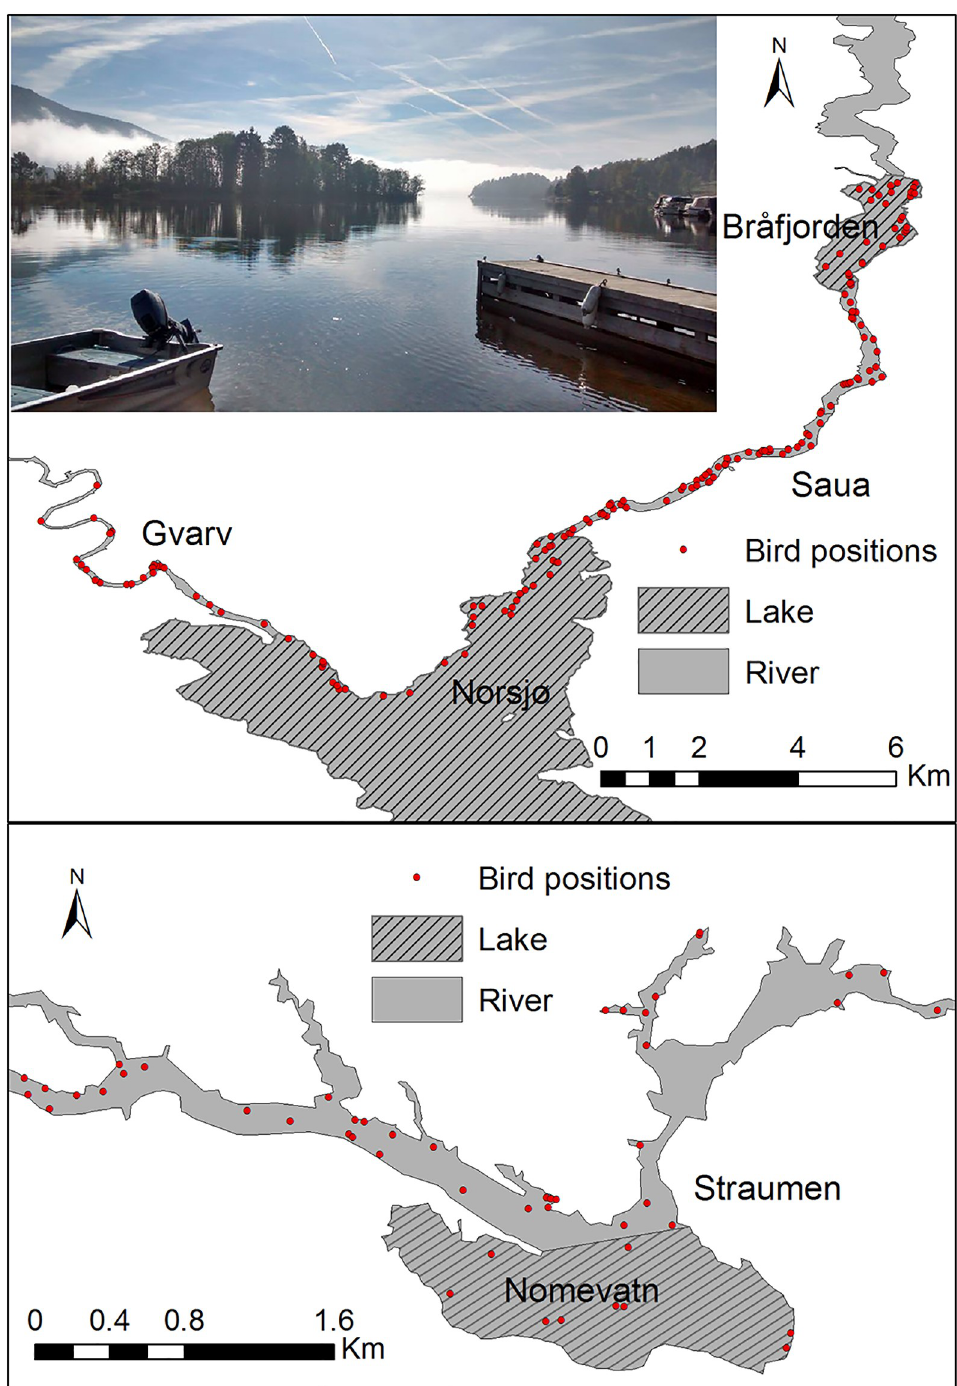
Fig 1. The study area in southeast Norway consisting of the rivers Gvarv, Saua and Straumen, and lakes Br å fjorden, Nomevatn and Norsj ø . Red dots show the GPS positions of approached birds (group sizes are not indicated).